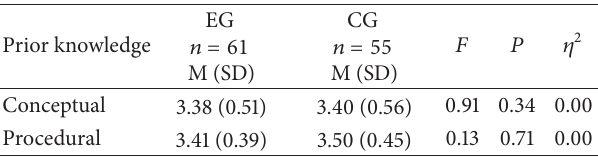
Table 3: Single factor ANOVA of prior knowledge before program (experimental and control).